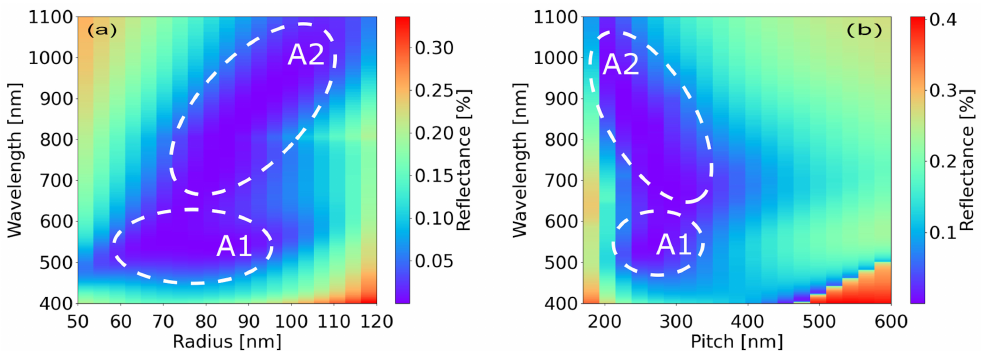
Figure 3. Reflectance of InP nanodisks on a Si substrate as a function of radius ( a ), pitch ( b ) and wavelength. A1 shows an area of minimal reflectance due to Mie type resonances in the structures and A2 minimal reflectance due to the effective refractive index impedance matching.